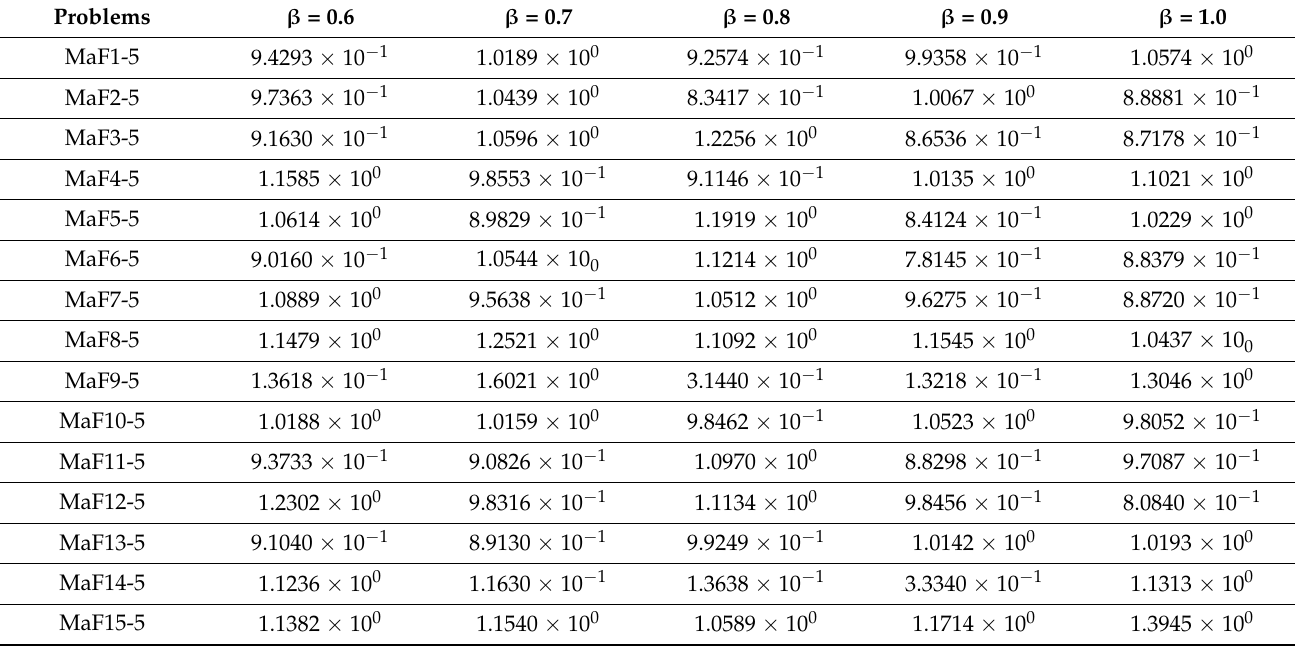
Table 4. IGD mean obtained by Two Arch-D with different β